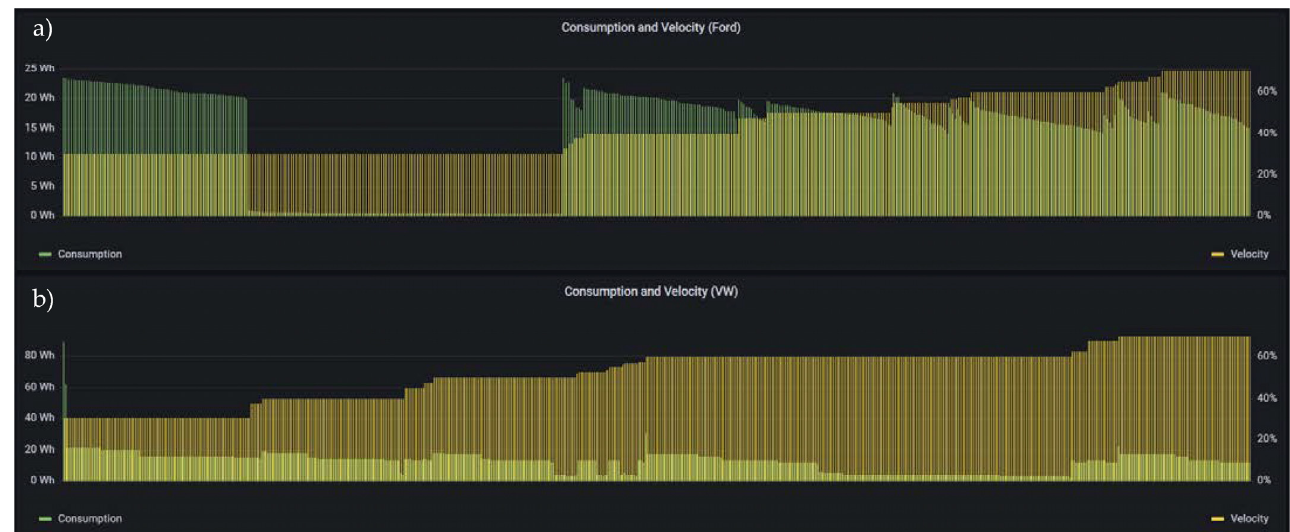
Figure 20. Consumption/Velocity Panel ( a ) for the Ford robotic cell and ( b ) for the VW robotic cell.